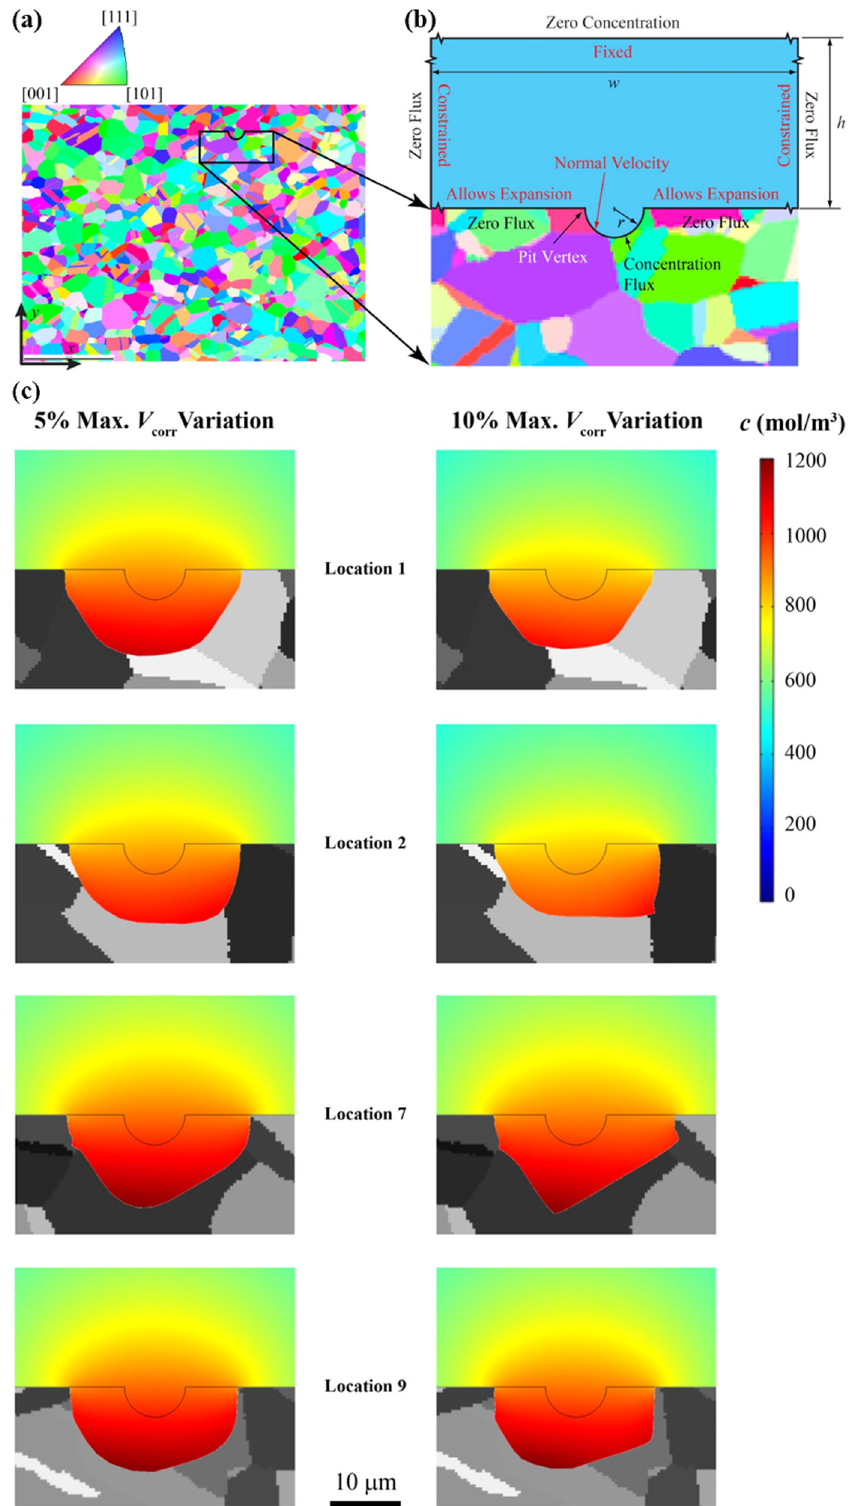
Fig. 5 Microstructure-sensitive modeling of pitting corrosion. a shows a random location in the microstructure (from EBSD mapping) for pit growth and b shows its associated boundary value problem within the electrolyte domain. c Comparison of grown pits at 100s at four locations in the microstructure for 5 pct. and 10 pct. maximum variations in potential with respect to the crystallographic orientation. c is metal ion concentration 79 . Reproduced with permission from ref. 79 , copyright (Elsevier,